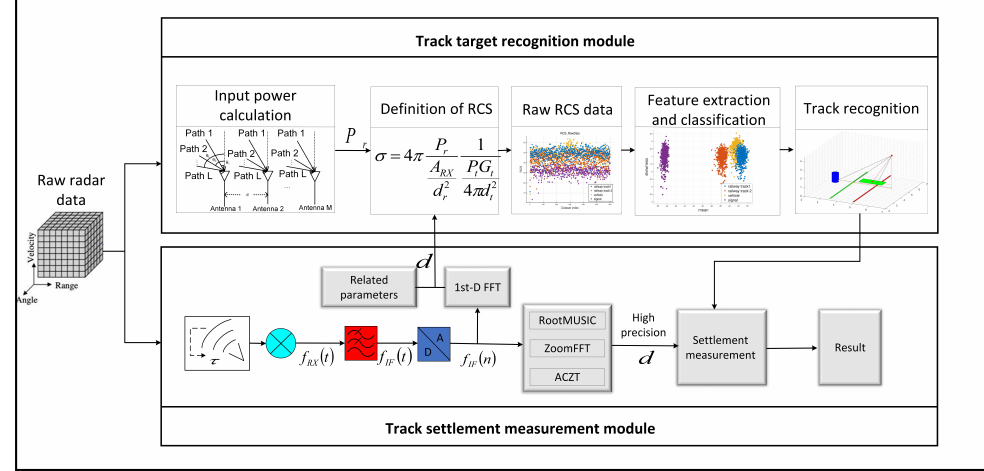
Figure 1. Railway track settlement measurement system based on millimeter wave